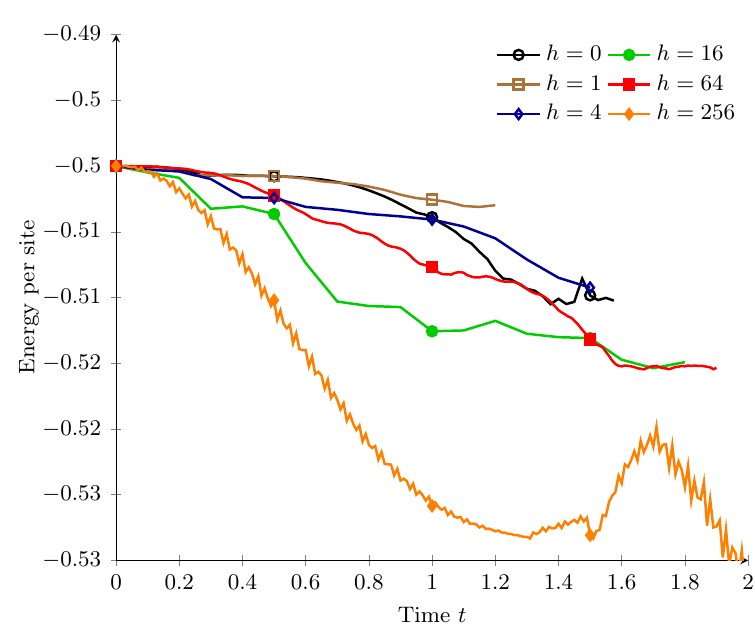
Figure 3: Energy per site over time at various disorder strengths. In all calculations, the error in energy is relatively small and typically smaller than the accumulated cost of truncation.